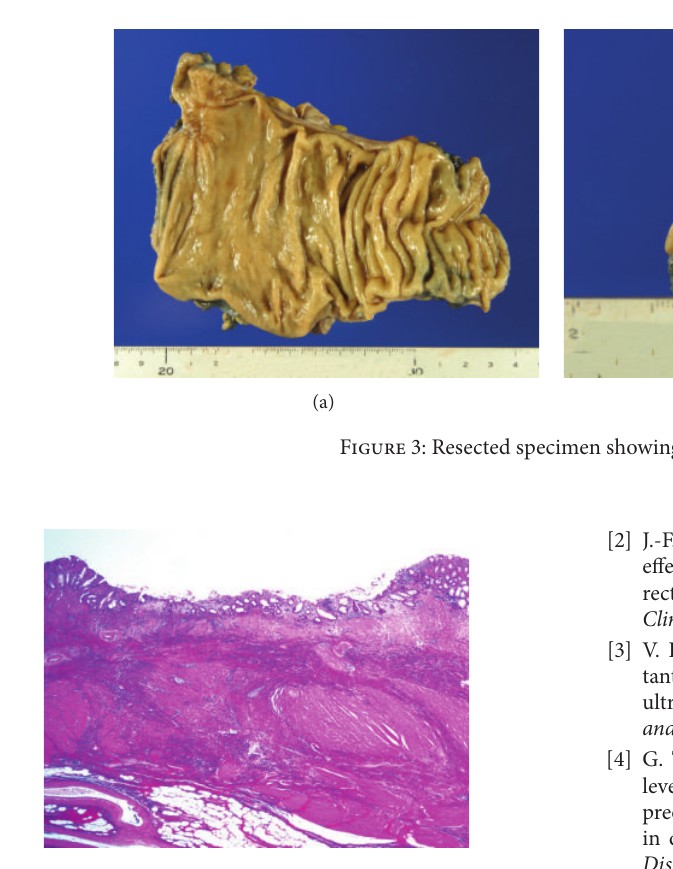
Figure 4: Pathological examination showing no tumor cells (hematoxylin-eosin